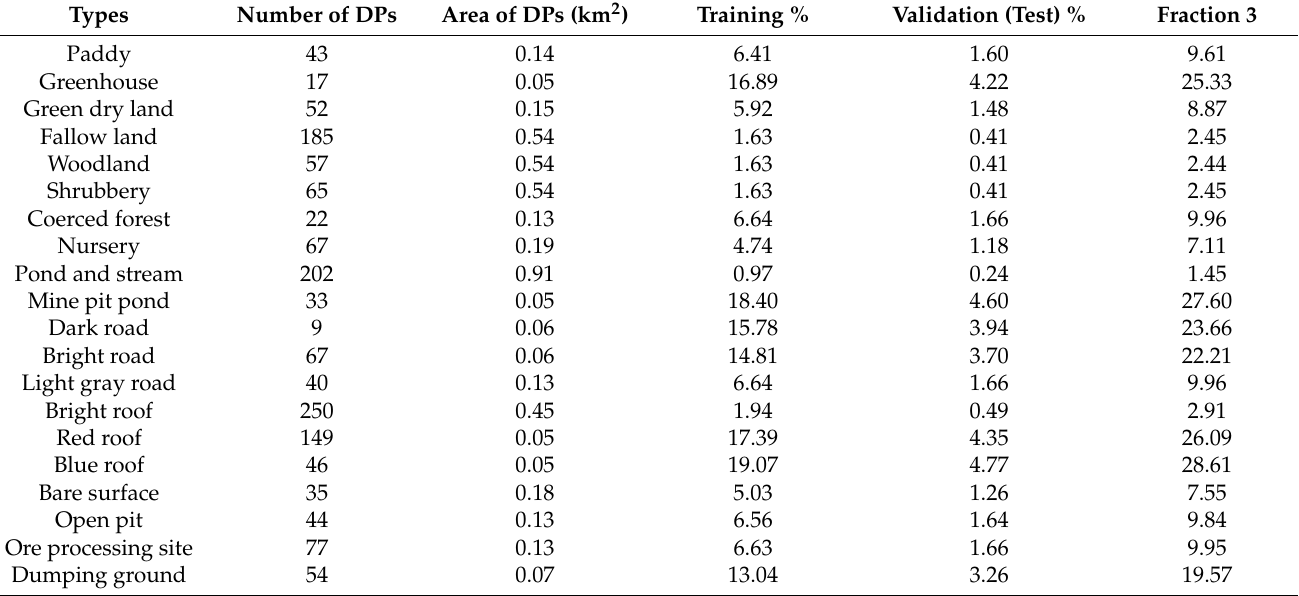
Table 2. Number and area (km 2 ) of data polygons (DPs) and fractions (%) of the training, validation, and test sets. Fraction 1: fraction of pixels in the training set and DPs; Fraction 2: fraction of pixels in the validation (test) set and DPs; Fraction 3: fraction of pixels in the three sets and